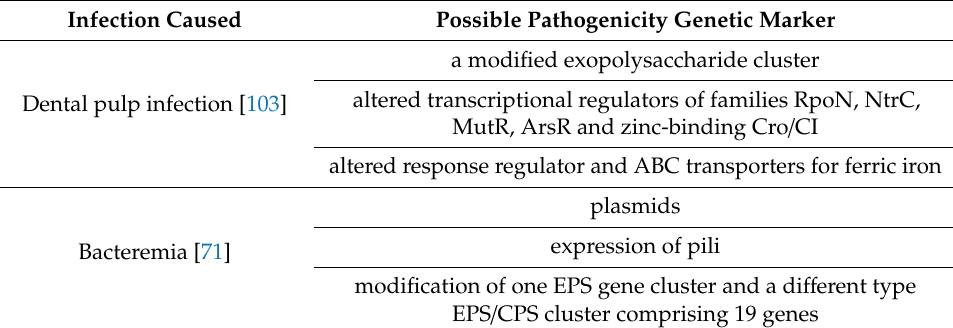
Table 3. Suggested genetic markers of L. rhamnosus